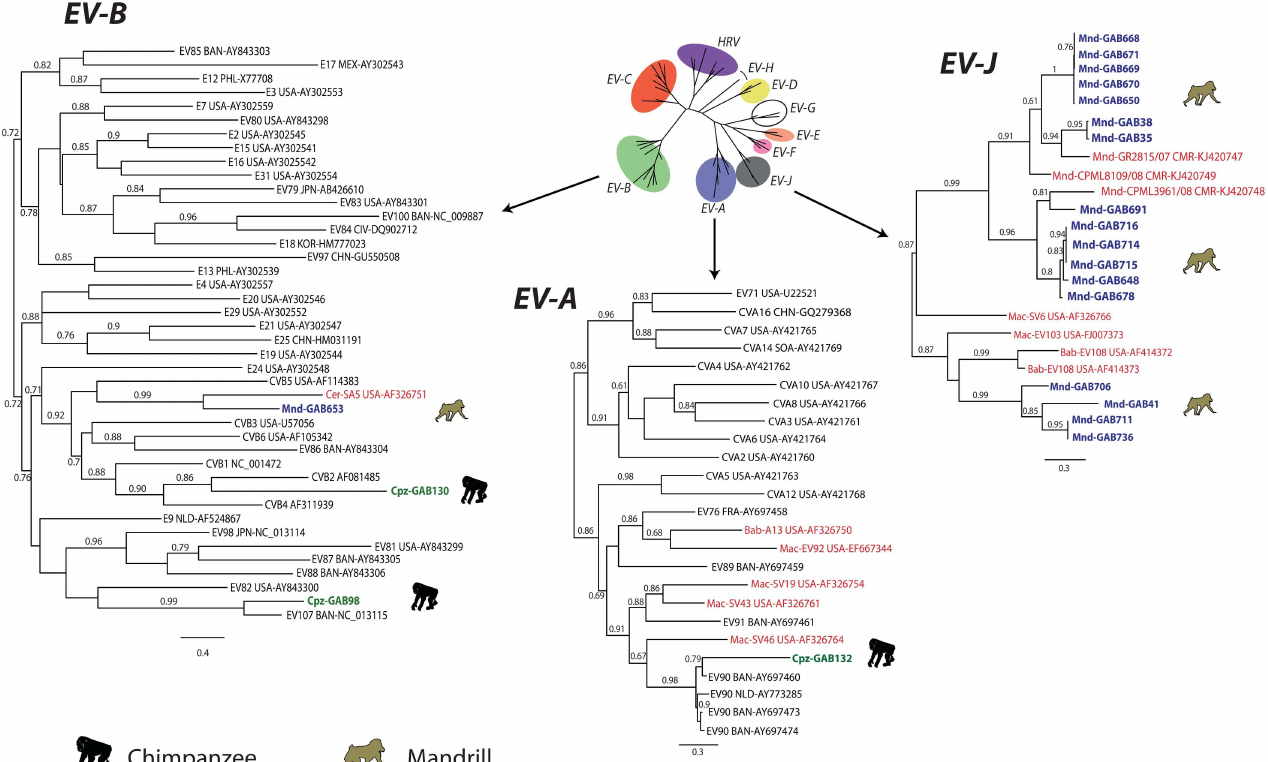
Fig 2. Phylogenetic relationship of EV strains based on approximately 450 nucleotides VP2 sequences (positions 962 to 1,545 according to the poliovirus 1 genome, Genbank # V01149),in the species EV-B , EV-A and EV-J . The genustree was constructed using the partial VP2 sequencesof representative serotypes of the genus Enterovirus by maximum likelihoodmethod. Sequences obtainedin this study are indicatedin blue for mandrillsand green for chimpanzees. Reference EV sequencesof other NHP species are indicatedin red. Names of NHP species are indicated(Mac for macaque,Bab for baboon, Cer for cercopothecus), countries are also indicated(BAN, Bangladesh;CHN for China; CIV for Ivory Coast; CMR for Cameroon;FRA for France; JPN for Japan; KOR for South Korea; MEX for Mexico; NLD for Netherland; PHL for Philippines;PUR for Puerto Rico; SLN for Slovenia; USA for United States of America; and SOA for Republicof South Africa). Trees were built using Maximum likelihoodalgorithmand GTR substitution model. Only bootstrapvalues (cid:21) 60% are indicatedat the nodes. Scale bars represent the genetic distance. GenBank accession numbersof the sequencesused are indicatedin the tree (for details, see S4 Table).